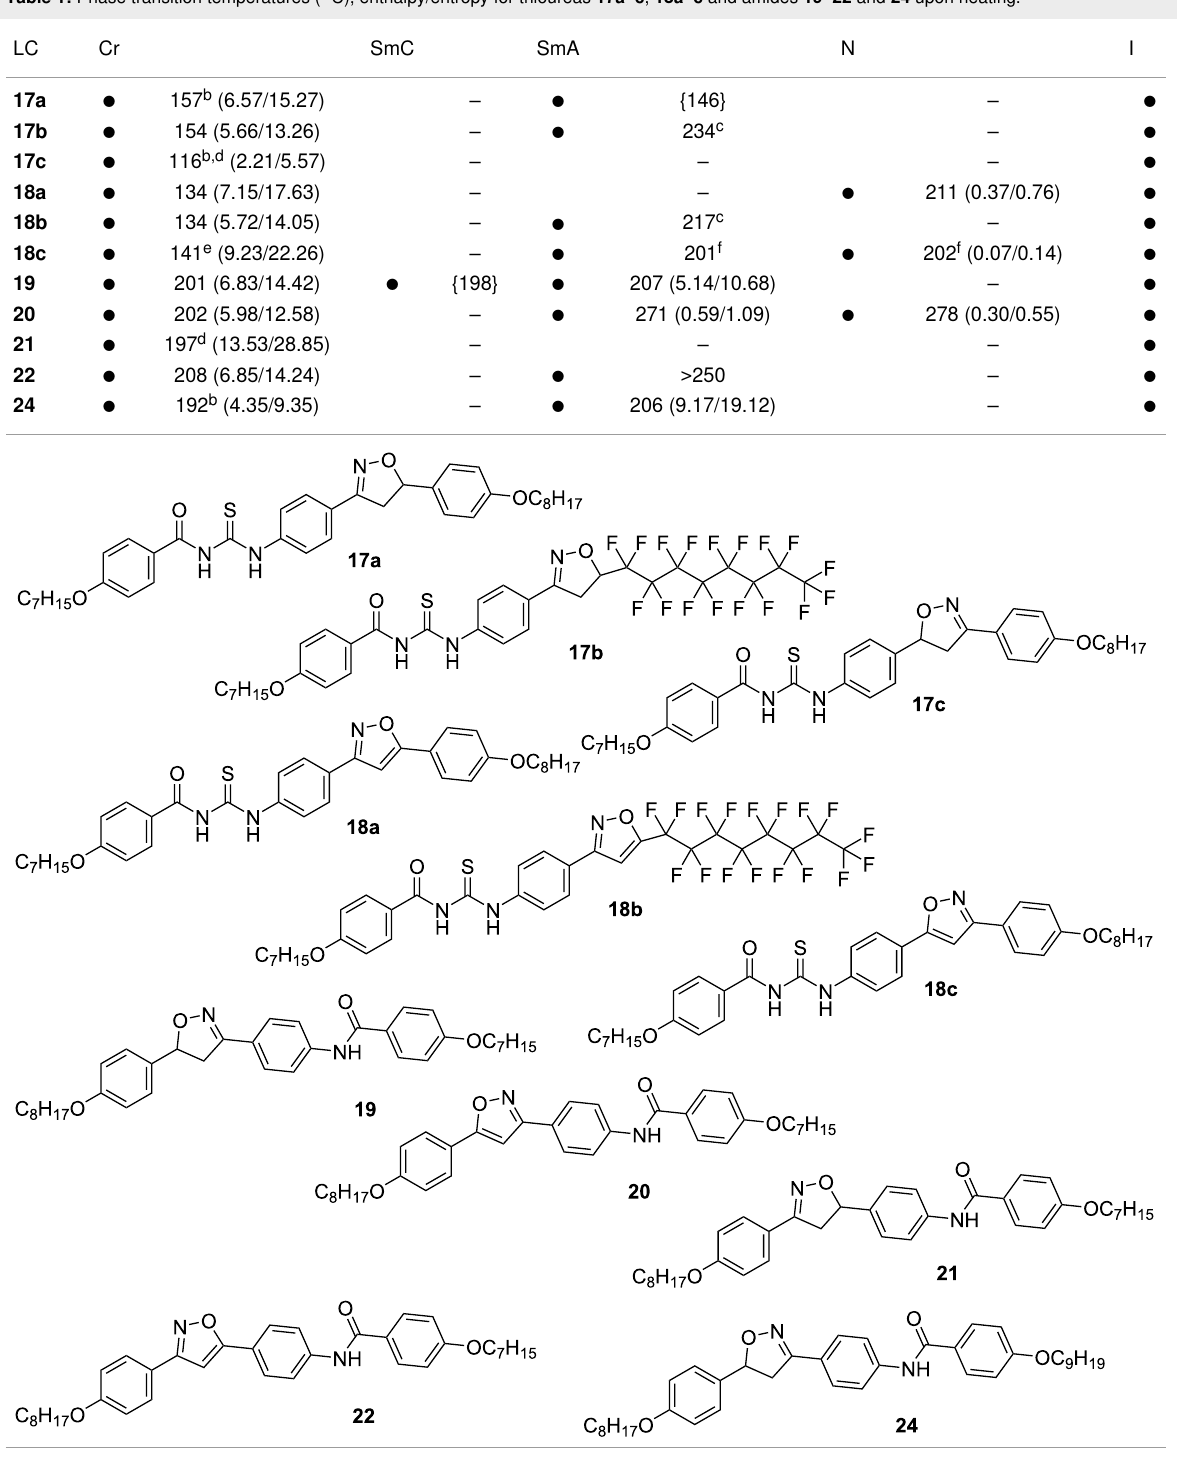
Table 1: Phase transition temperatures (°C), enthalpy/entropy for thioureas 17a – c , 18a – c and amides 19 – 22 and 24 upon heating. a